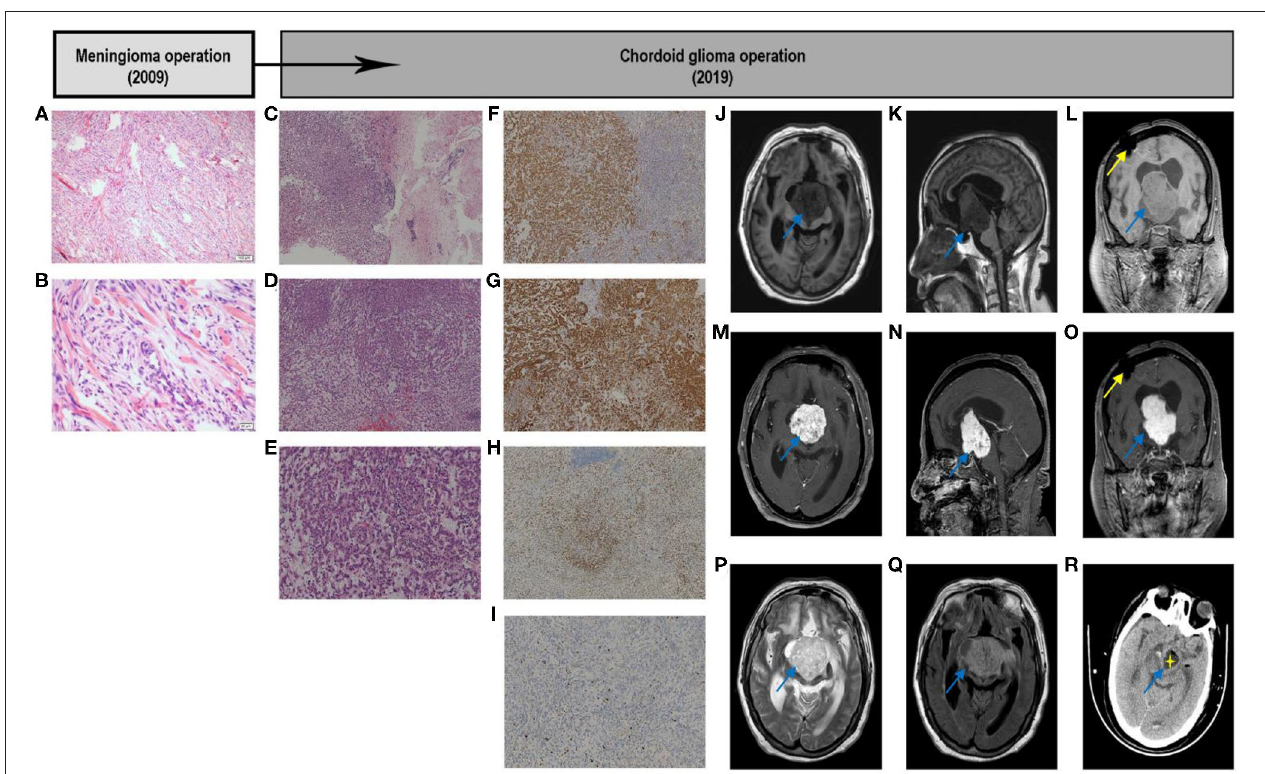
FIGURE 1 | Graphic summary of case. Fibrous meningioma. Hematoxylin–eosin. Low-magnification images showing that tumor cells are ovoid and arranged in bundles and swirls (A) . High-magnification images showing that tumor cells are arranged in bundles and swirls, with focal fibrous proliferation. The tumor cells are ovoid and short fusiform, with a non-mitotic phase (B) . Chordoid Glioma. Hematoxylin–eosin. Low-magnification images showing tumor tissue on the left and brain tissue on the right, and part of the boundary between the two is unclear. Tumor cells are arranged in chords, clusters, and crack, with mucus, lymphocytes, and plasma cells in the stroma (C) . The tumor cells are arranged in cords of epithelioid and nest, with a mucus, lymphocytes and plasma cells in the stroma (D) . The tumor cells are fairly uniform, with plenty of cytoplasm, eosinophilic, and medium nucleus, most were in a non-mitotic phase, with mucus, lymphocytes, and plasma cells in the stroma (E) . Immunohistochemical. Immunostaining GFAP demonstrated cytoplasmatic diffuse and strong expression in tumor cells (F) ; CD34 showed cytoplasmatic positivity in tumor cells (G) ; TTF - 1 showed nuclear positivity in most cells (H) ; Ki-67 showed slight nuclear positivity in cells and a low proliferation